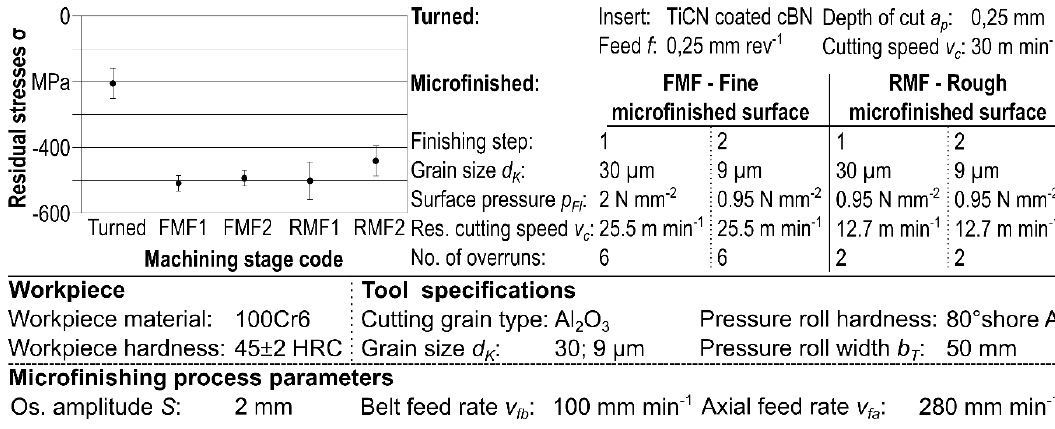
Figure 9. Residual stresses after surface machining by turning and microfinishing.